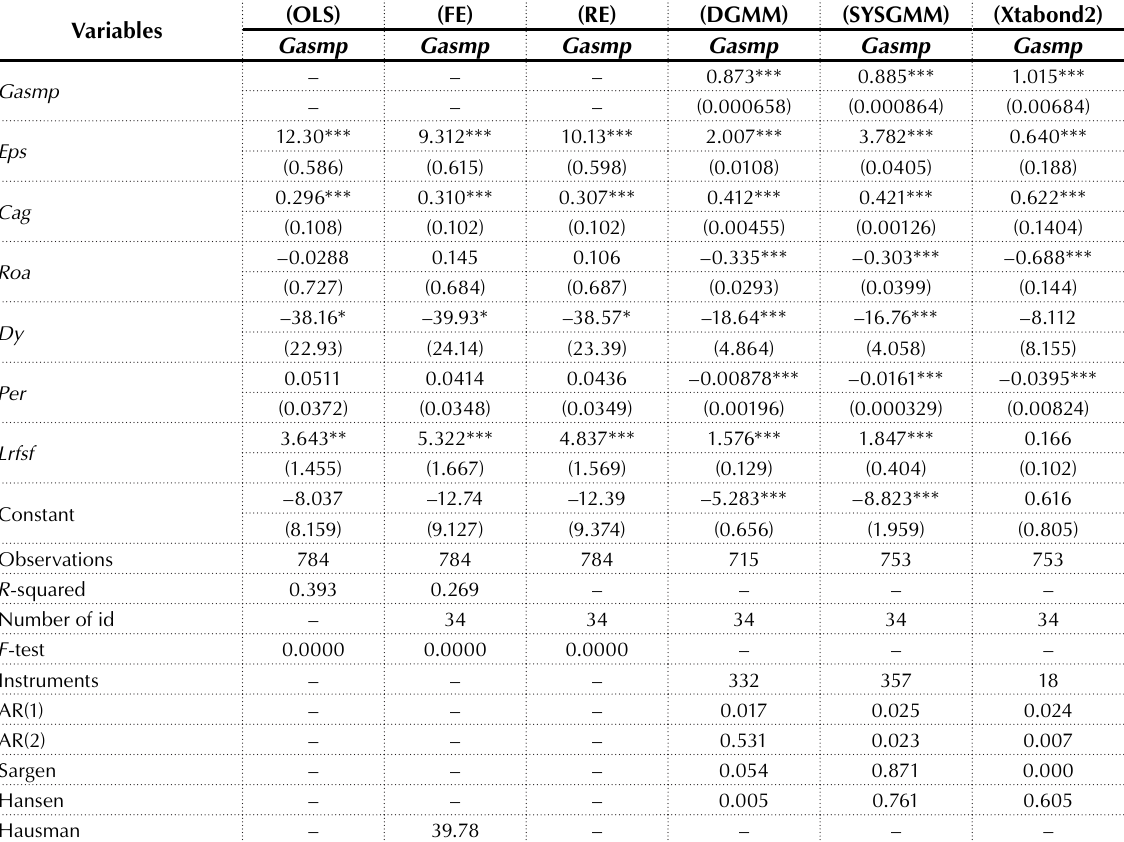
Source: Computed by the researcher using STATA